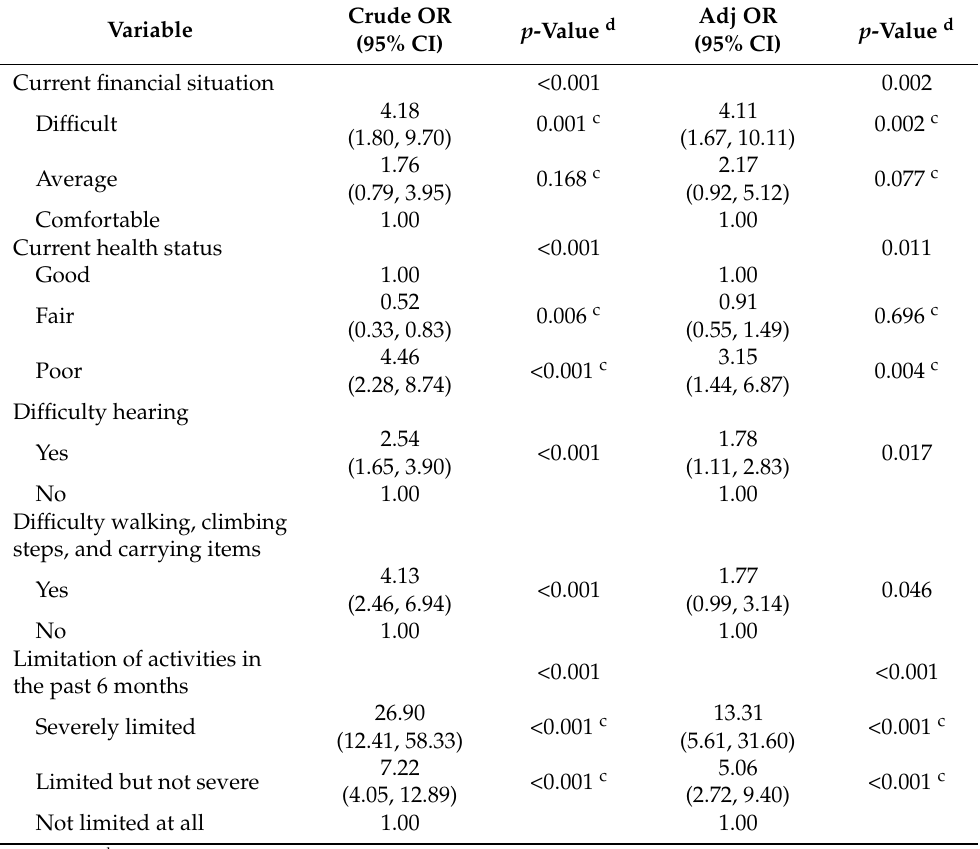
Table 3. Factors associated with the need for assistance.